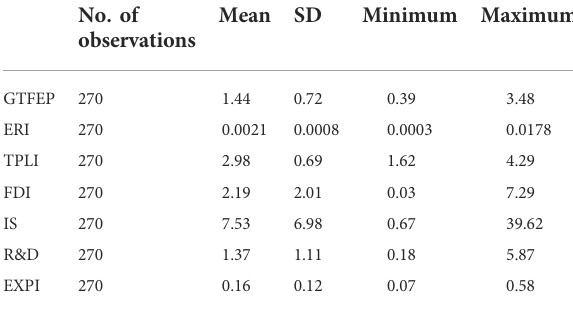
TABLE 2 Descriptive statistics of